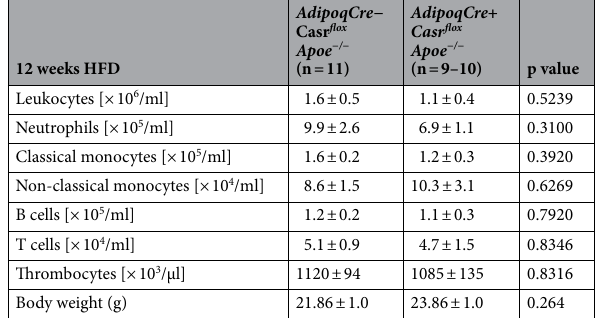
Table 2. Body weight and immune cells in blood in mice fed with HFD for 12 weeks. Analysis has been done using FACS Diva software 8.0.3 (www. bdbio scien ces. com) and FlowJo 10.7 (www. flowjo. com).